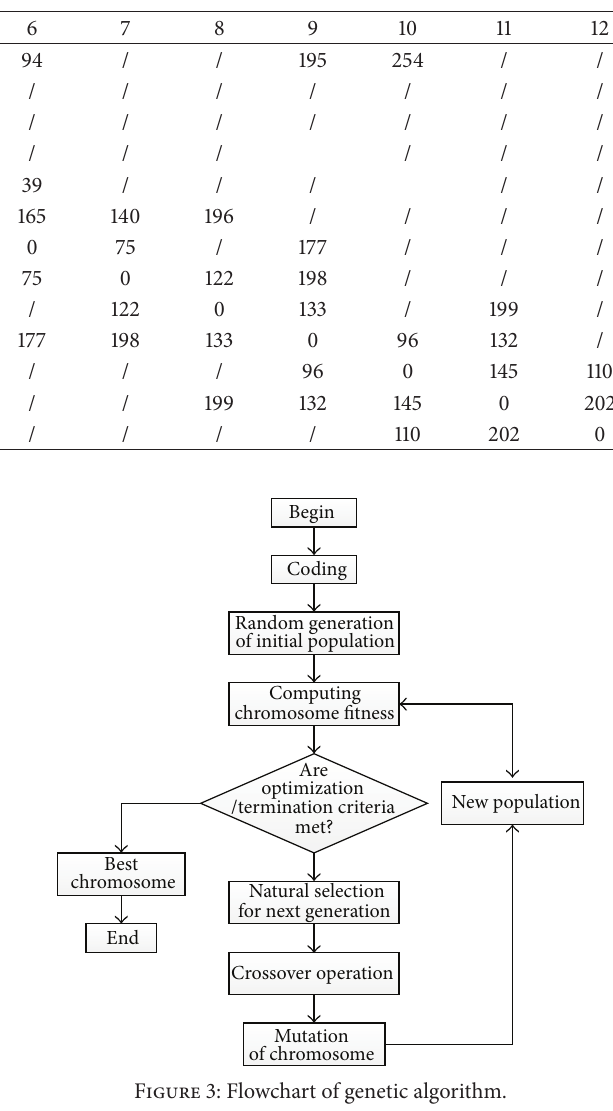
Table 2: Distance between different cities.